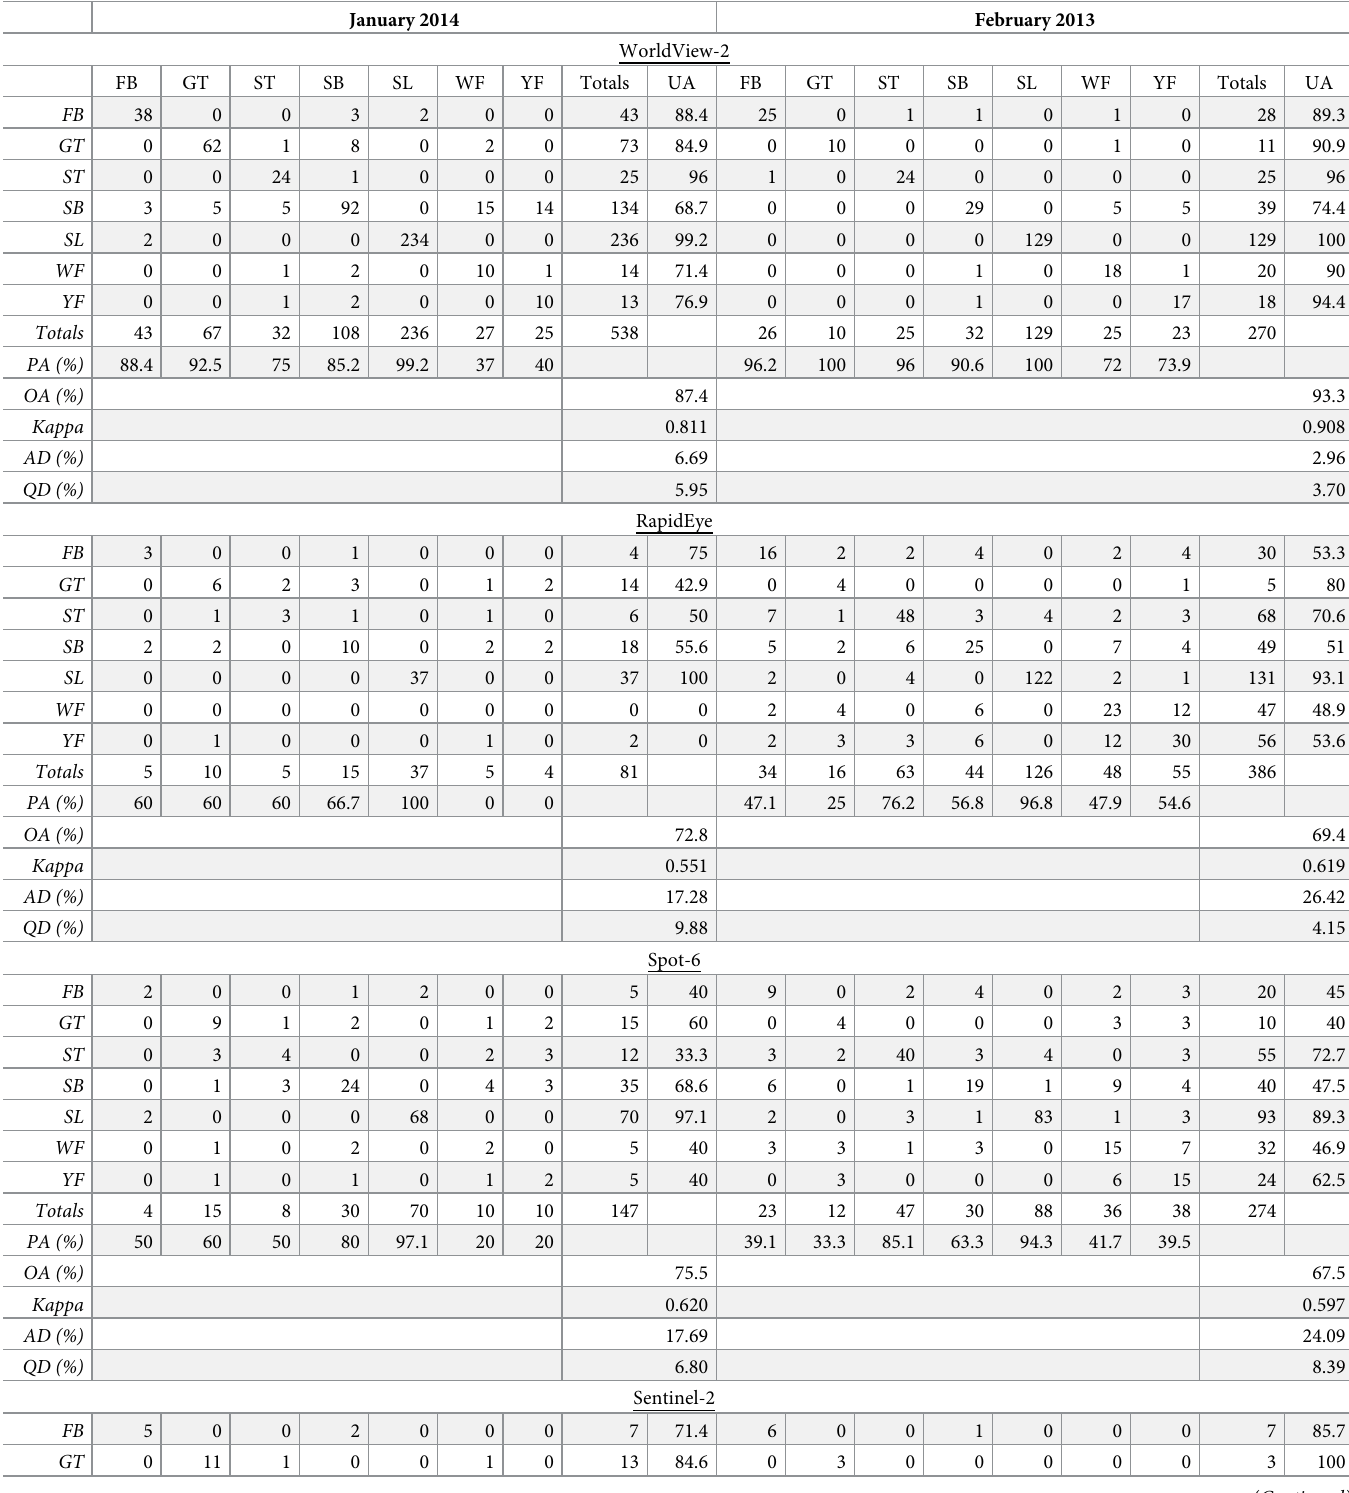
Table 6. Confusion matrix for the classification of flowering vegetation communities in the Mwingi study site obtained using random forest classifier and resam- pled simulated WorldView-2, RapidEye, Spot-6 and Sentinel-2 datasets for onset of flowering (January 2014) and maximum flowering (February